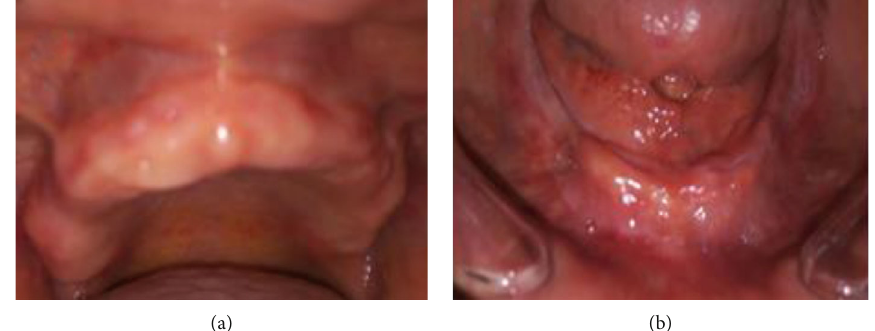
Figure 3: Intraoral examination: (a) in fl amed maxillary fi bromucosa and (b) in fl amed and fl abby tissue in the mandibular anterior region.